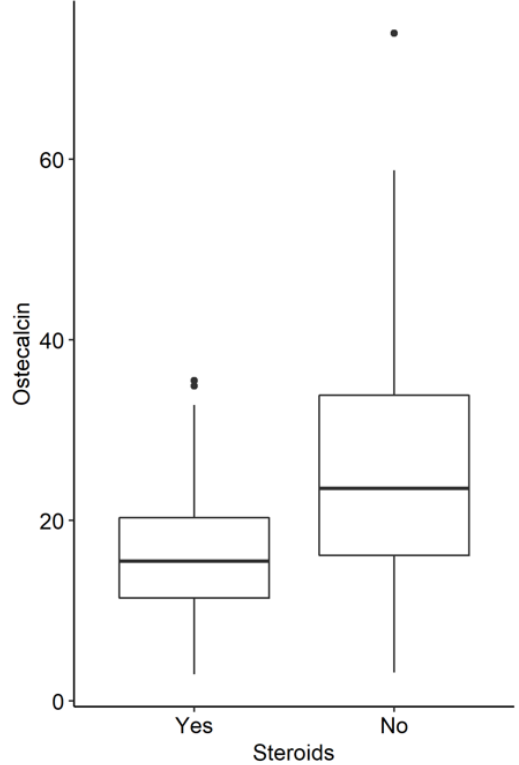
Figure 3. Osteocalcin levels in IBD patients with and without steroids ( p < 0.001).